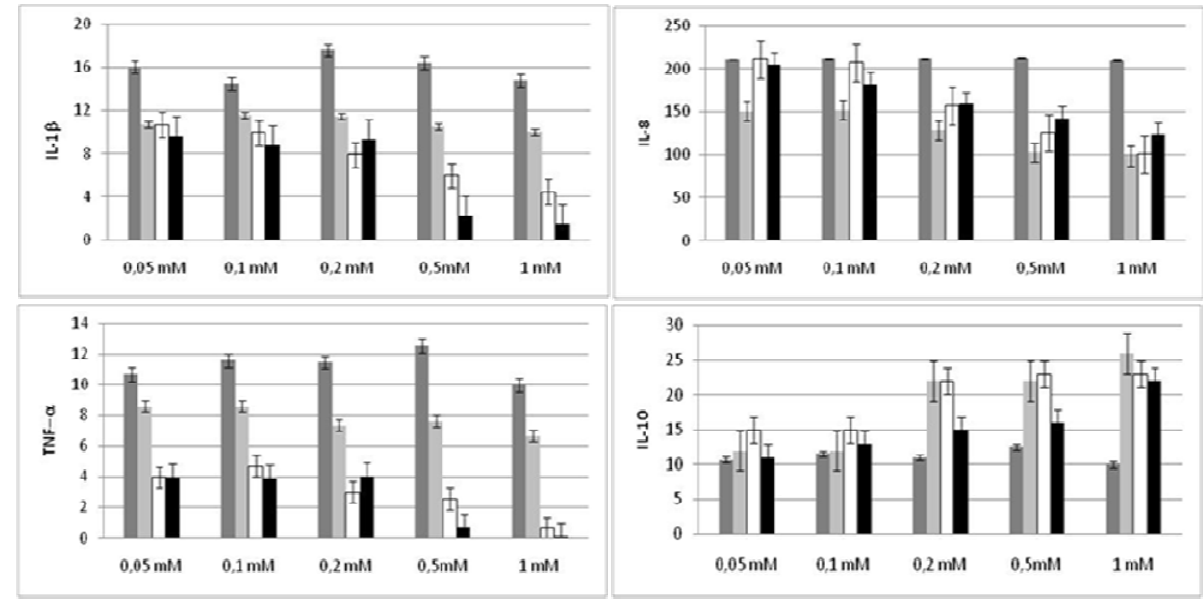
Figure 3. Cytokines levels in HepG2 cell line after 72 h of